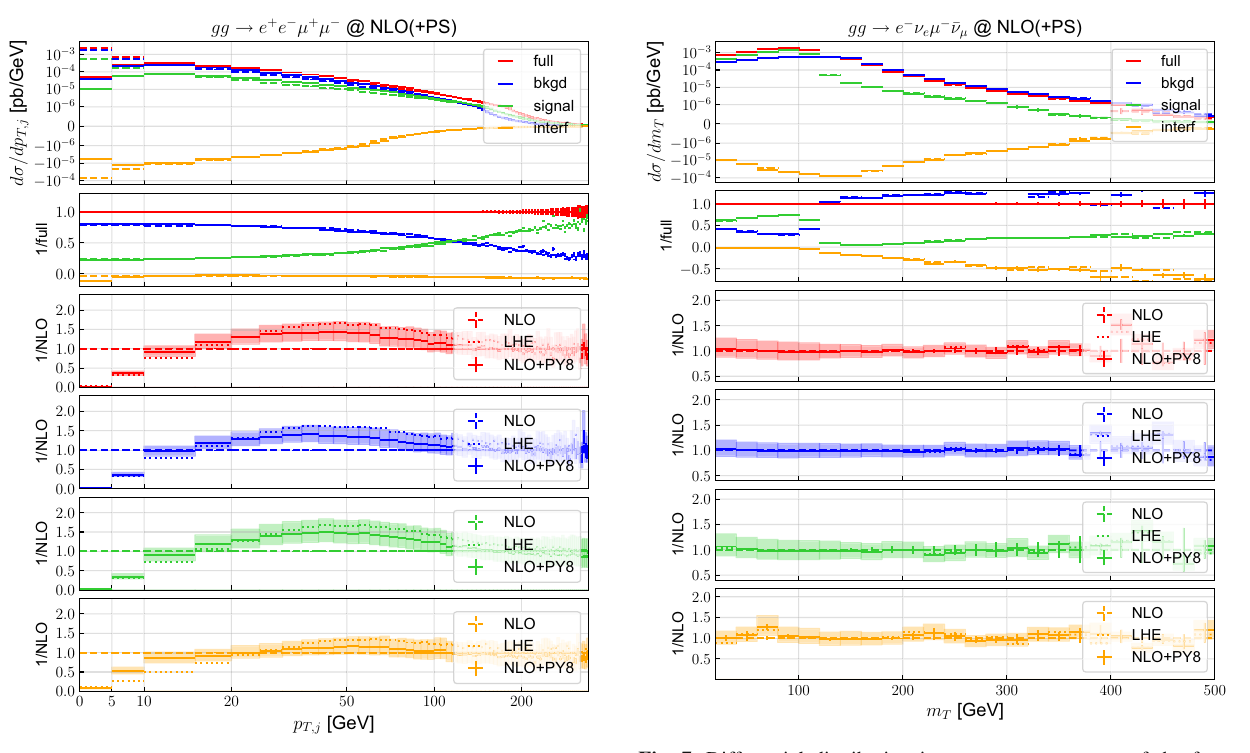
Fig. 6 Differential distribution in the transverse momentum of the hardest jet p T , j in gg → e + e − μ + μ − at NLO matched to PYTHIA 8 . 1 Predictions, colour coding and bands as in Fig. 3